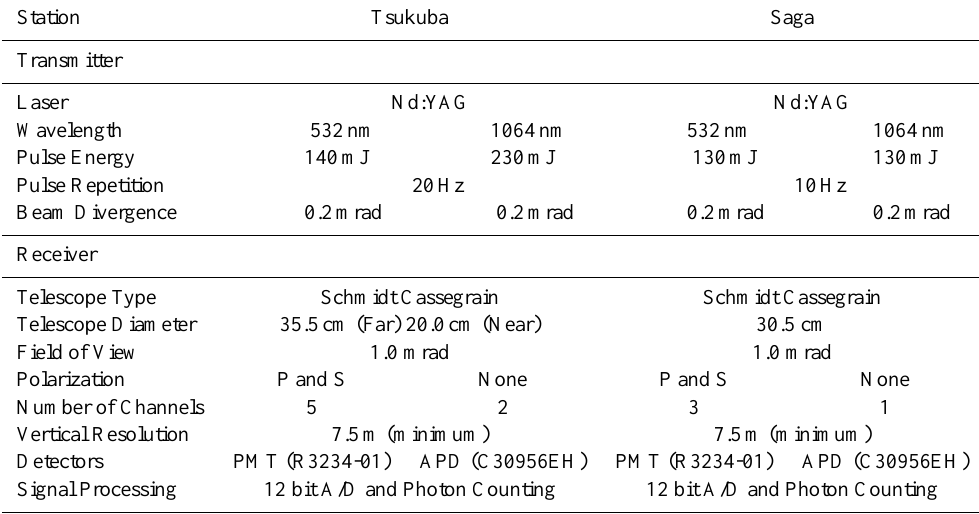
Table 1. Characteristics of two-wavelength polarization lidar systems at Tsukuba and Saga. Station Tsukuba